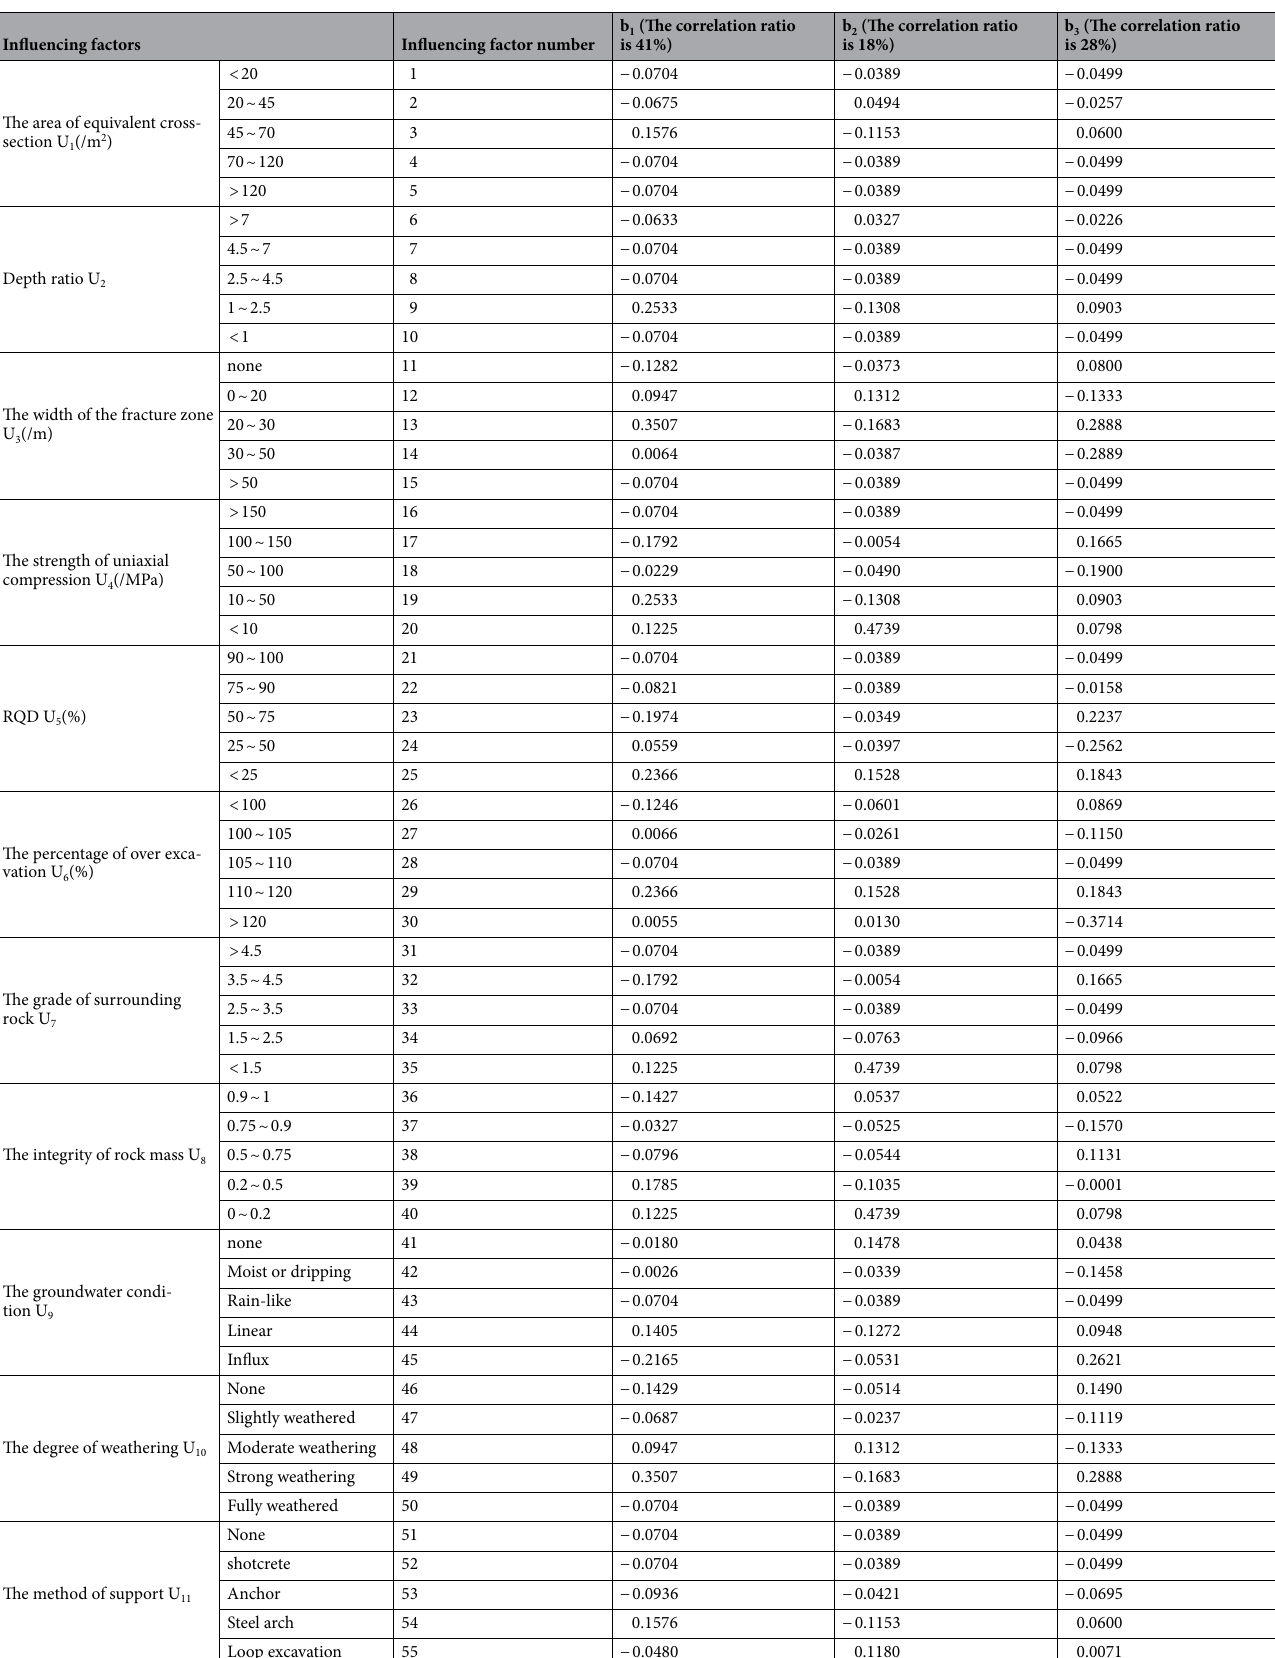
Table 3. Influencing factor category